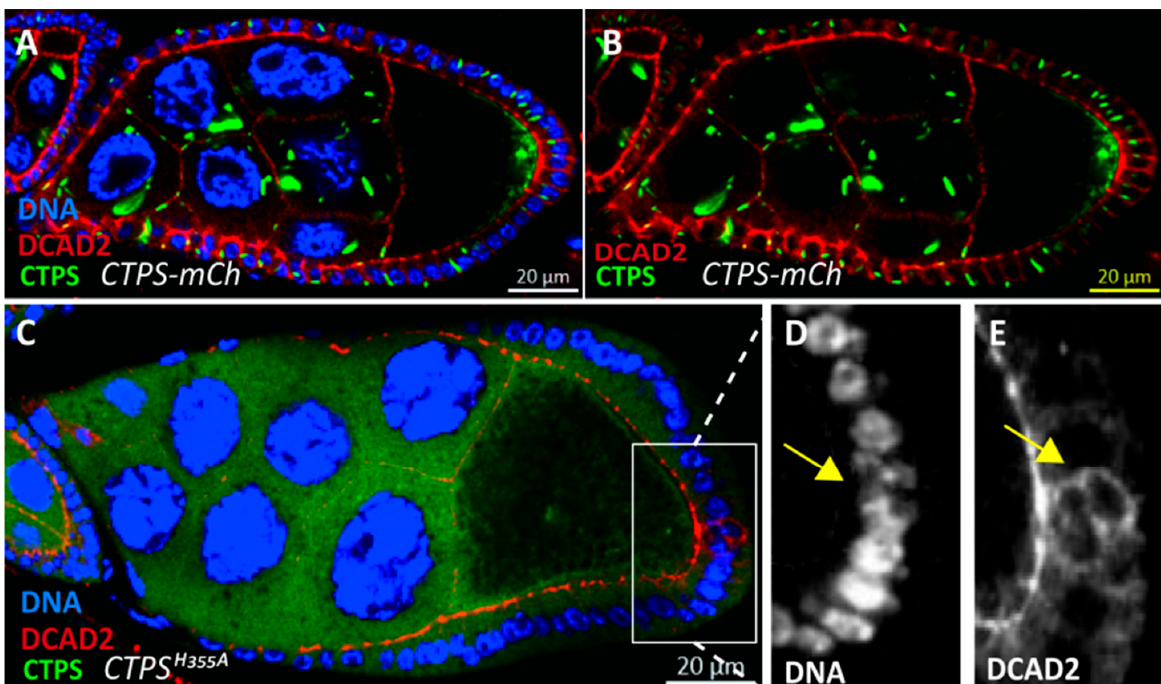
Figure 6. DCAD2 distribution is disturbed in CTPS H355A follicle epithelia. ( A ) Cross section of Drosophila egg chamber expressing CTPS labelled by mCherry. The part of the follicle cell adjacent to the nurse cell is called apical, and the DE-Cadherin labeled by DCAD2 (red) is located at the apical of follicle cells. ( B ) DCAD2 together with CTPS as control to show the normal distribution of DCAD2. ( C ) Lateral view of a CTPS H355A –mCh egg chamber with abnormal follicle cell. ( D ) Yellow arrow pointed to the follicle cell ingression. ( E ) Ingressive folllicle cell pointed to by yellow arrows show abnormal distribution of DCAD2.